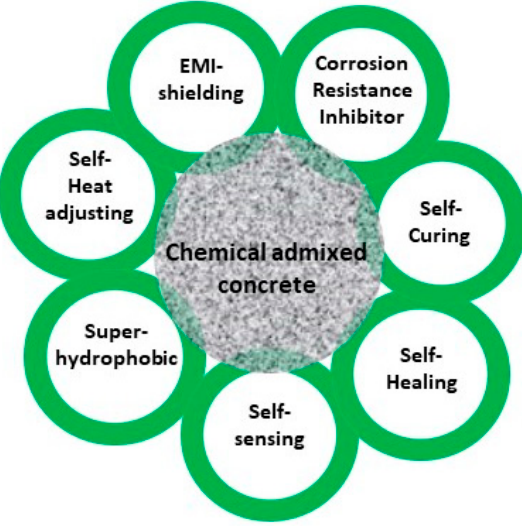
Figure 9. Various applications of chemical admixtures used in concrete